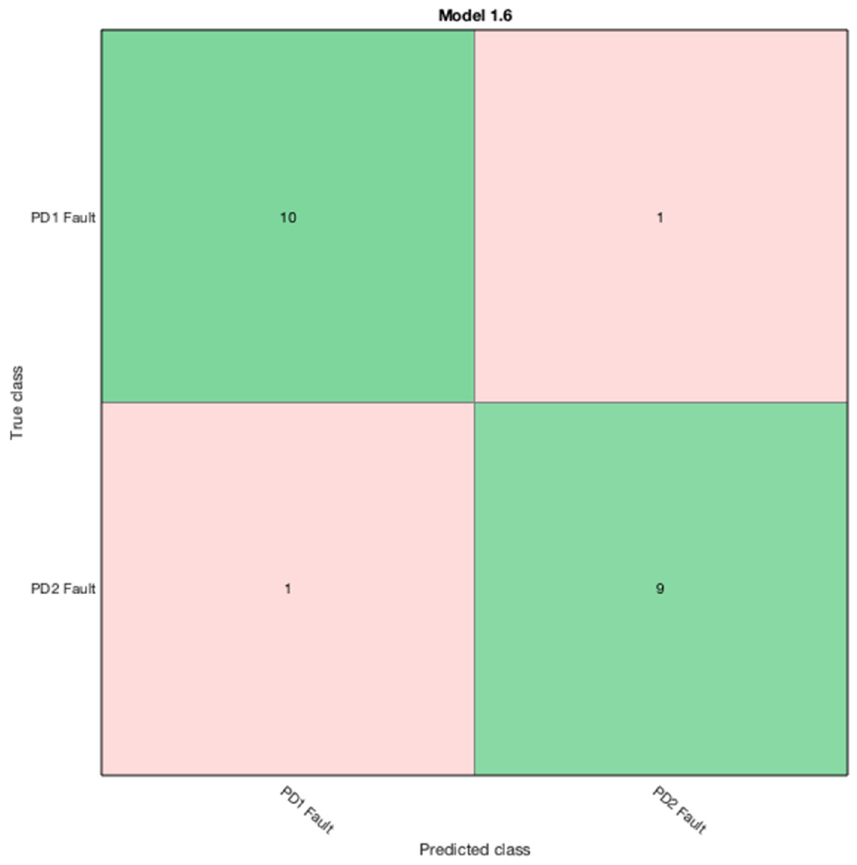
Figure 13. Confusion matrix for SVM 3 classifier.